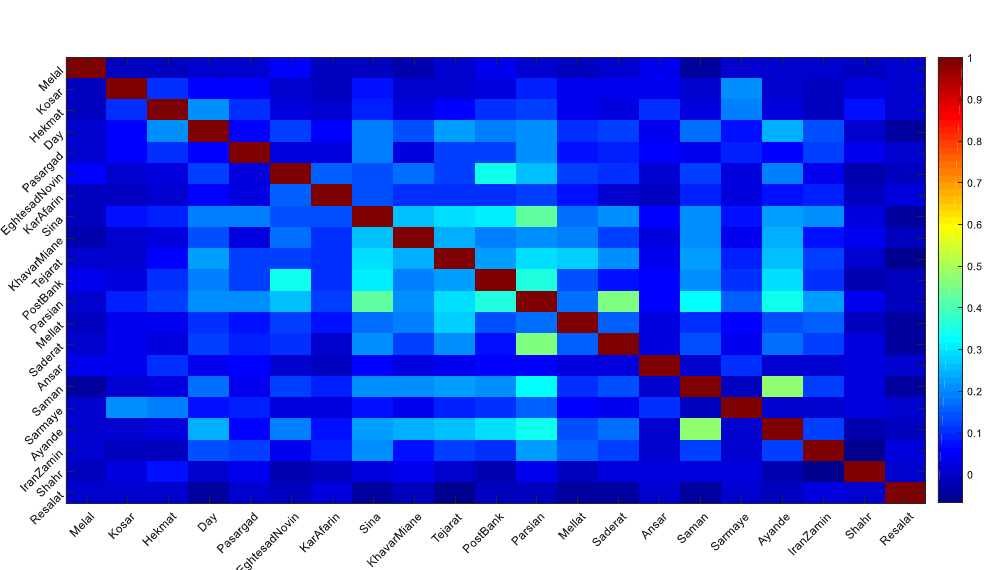
Figure 1. Color image of the cross-correlation matrix.